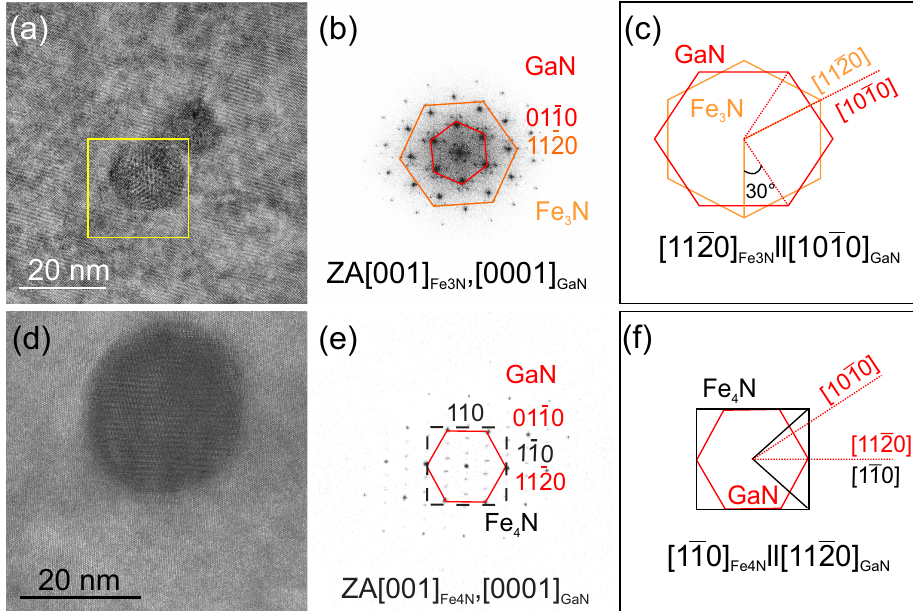
Figure 6. Plan-view HRTEM images of exemplary Fe y N nanocrystals embedded in a Ga δ FeN layer grown on ( a ) an Al 0.1 Ga 0.9 N buffer, and ( d ) GaN. ( b , e ) FFT of the images presented in ( a , d ), respectively, showing the epitaxial orientation of the NCs with respect to the GaN matrix. The FFT in ( c ) corresponds to the NCs marked by the square in ( a ). ( c , f ): Schematic representation of the epitaxial relation in ( b , e